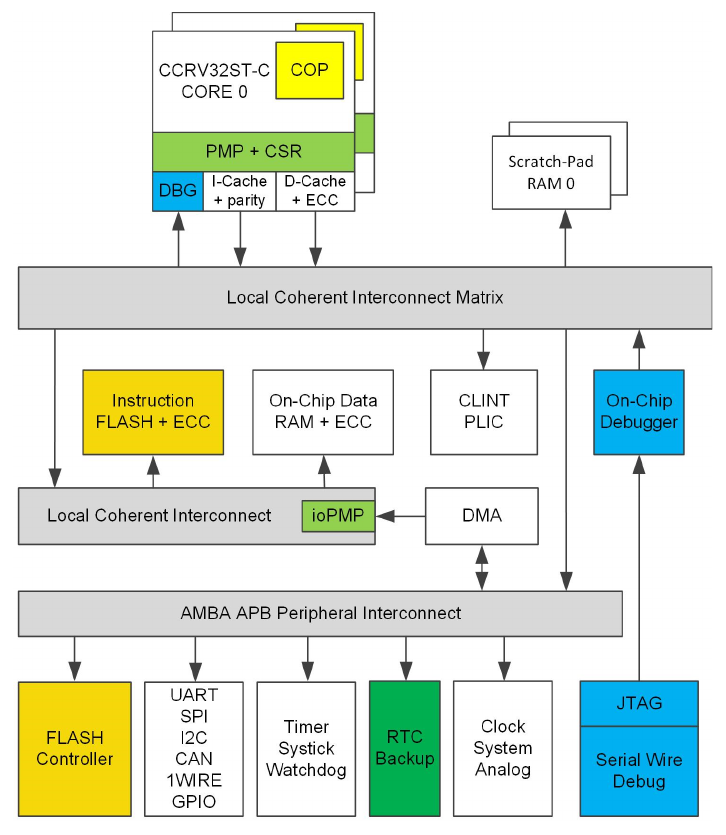
Figure 3. Block diagram of a typical CCRV32ST processor system-on-chip.